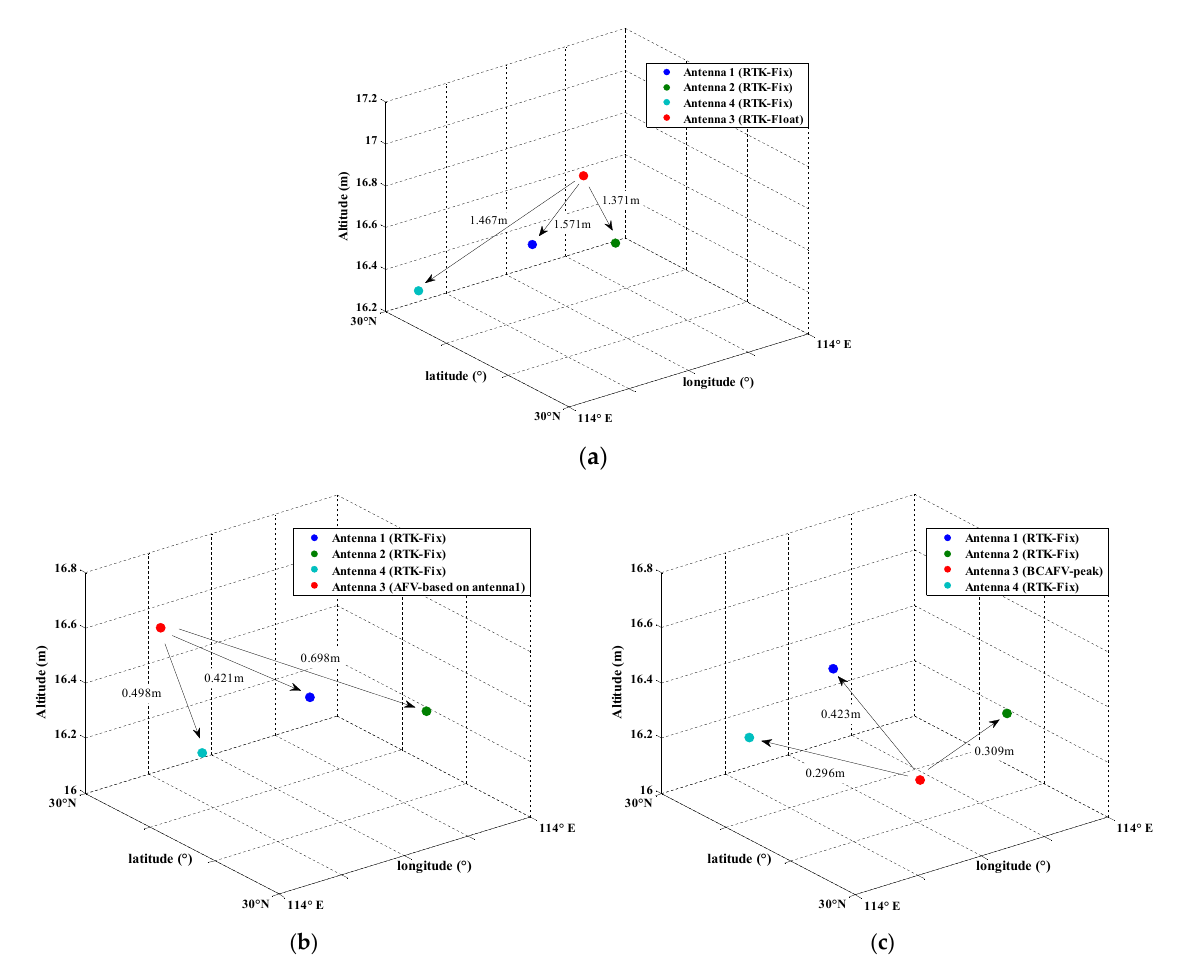
Figure 6. Spatial distribution of four antennas in different positioning modes. ( a ) Antennas 1, 2 and 4 are RTK fixed solution positions, and antenna 3 is float solution position. ( b ) Antenna 3 is Peak1 obtained by AFM in Table 4, also the peak in Figure 5b. ( c ) Antenna 3 is Peak2 obtained by BCAFM in Table 4, also the peak in Figure